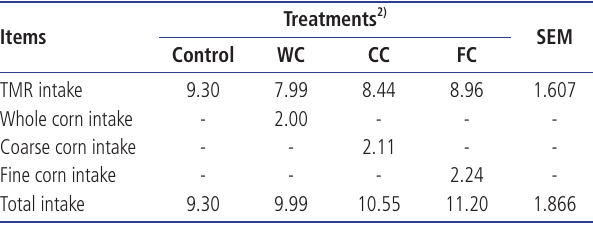
Table 2. Effect of feeding Korean domestic corn grain by different particle size on dry